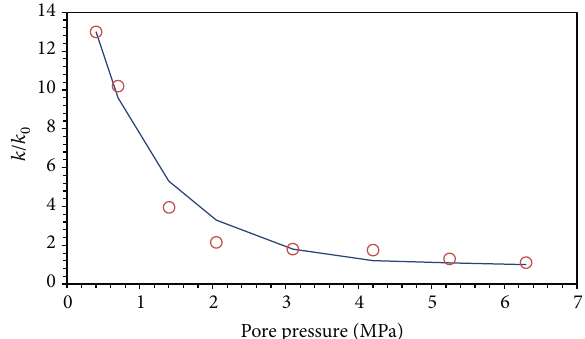
Figure 3: Comparisons between the calculated results of the model and fi eld data.